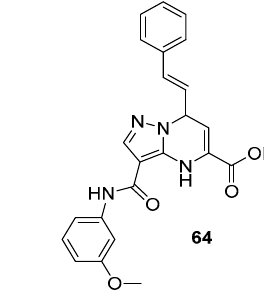
Figure 25. Chemical structures of N -substituted phenyl amide analogues. From left to right: general structure 14 of N -substituted phenyl amide analogues. Chemical structure of compounds 63 and 64 .